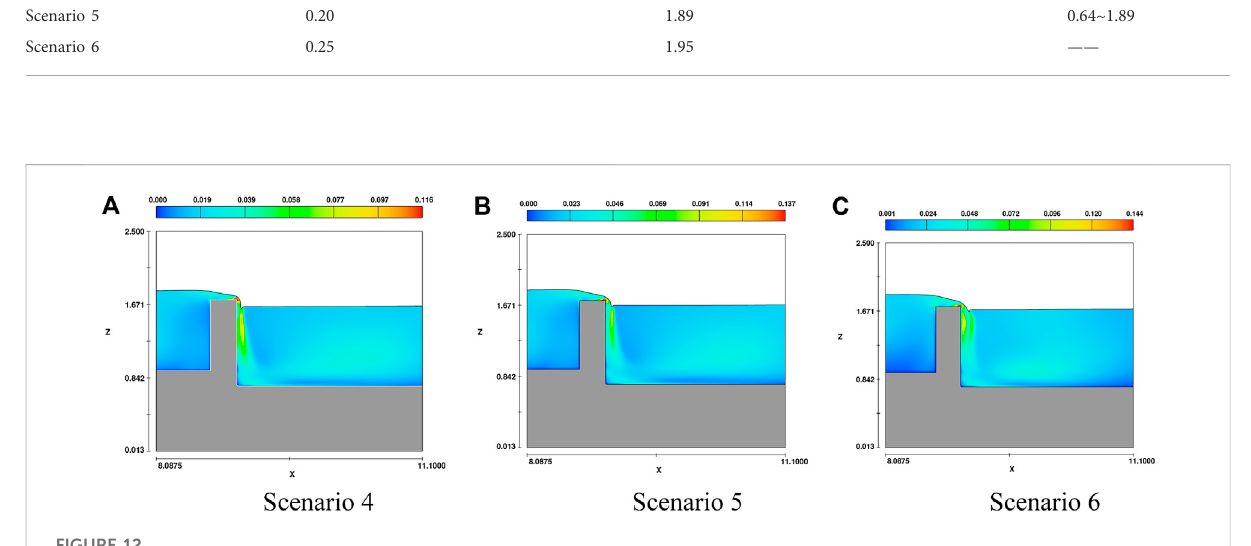
FIGURE 12 Turbulent kinetic energy diagram under different